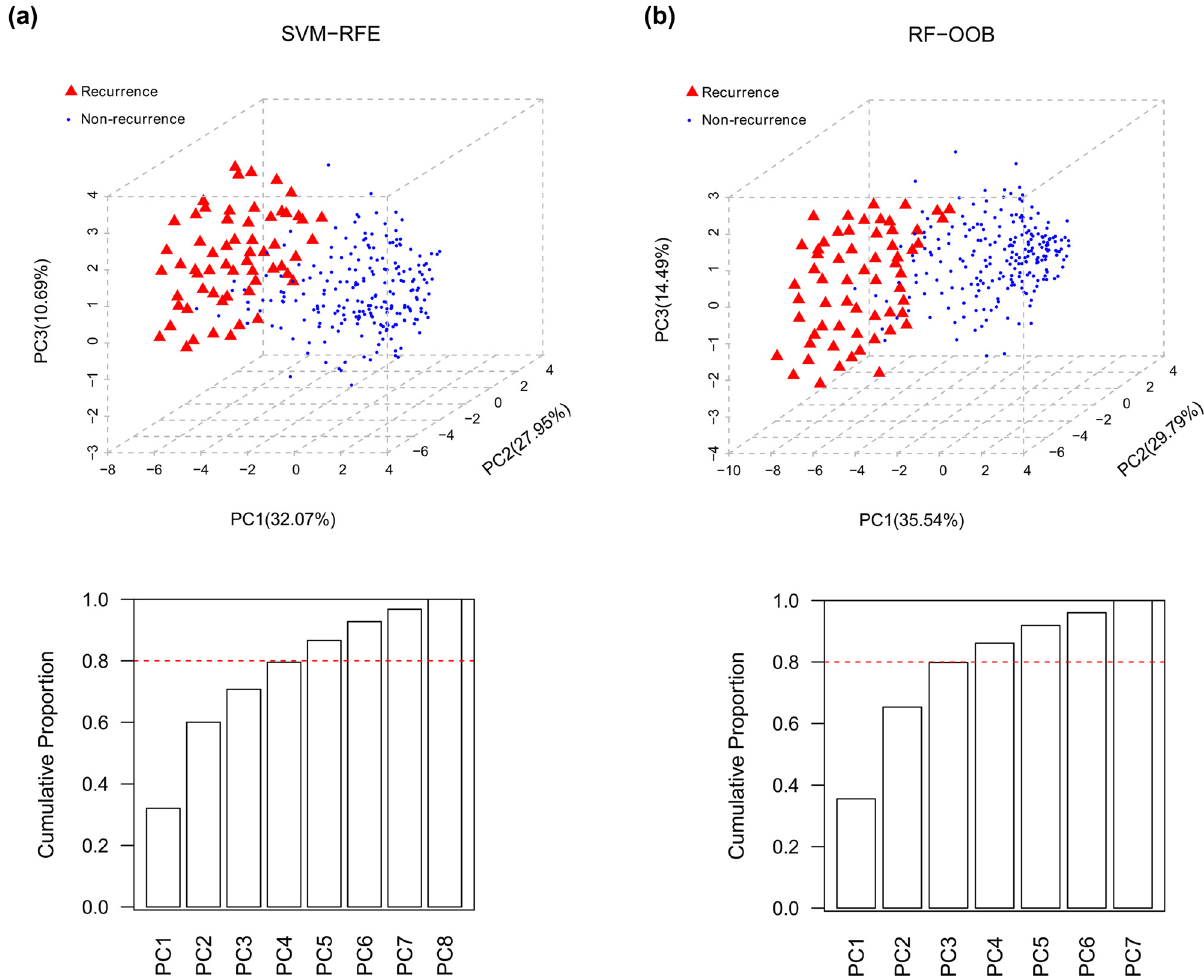
Figure 3: Comparative analysis of SVM – RFE ( a ) and RF – OOB ( b ) by PCA approach. Upper images illustrate 3D PCA plot of PC1, PC2, and PC3. Recurrence and nonrecurrence samples are labeled in red triangles and blue balls, respectively. Below images exhibit cumulative con - tribution of di ff erent PCs. The red dashed line indicates cumulative proportion of 80%.